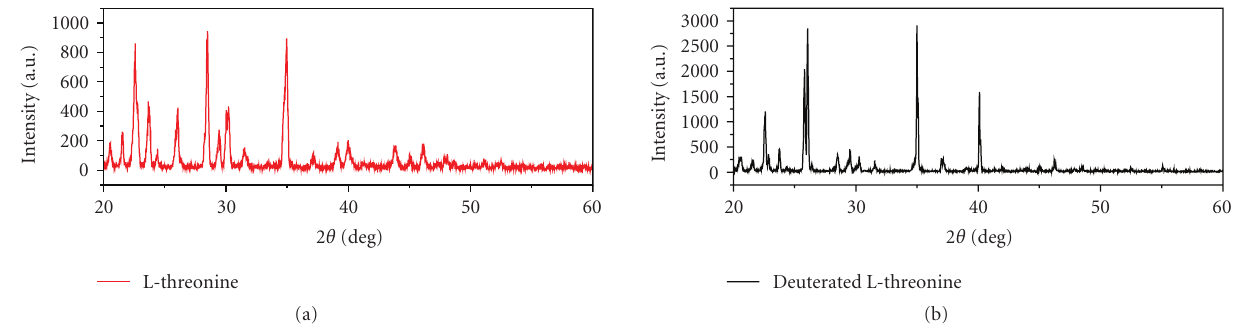
Figure 30: Powder X-ray di ff raction of L-threonine and deuterated L-threonine.